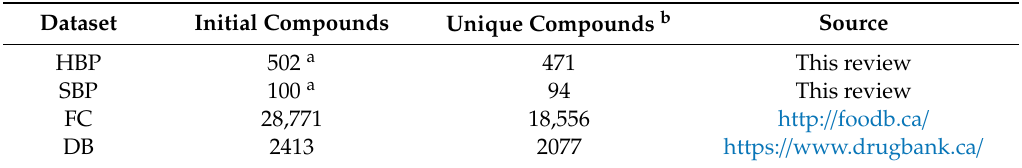
Table 3. Summary of the datasets used for comparison.